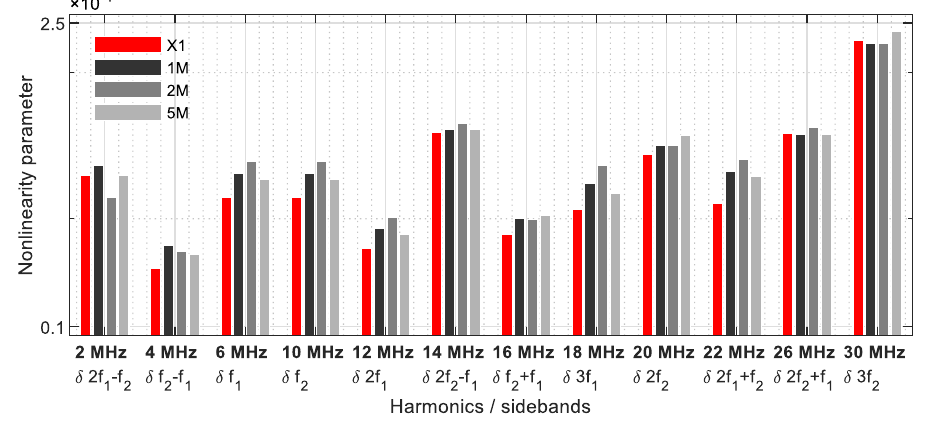
Figure 13. Nonlinearity parameter.